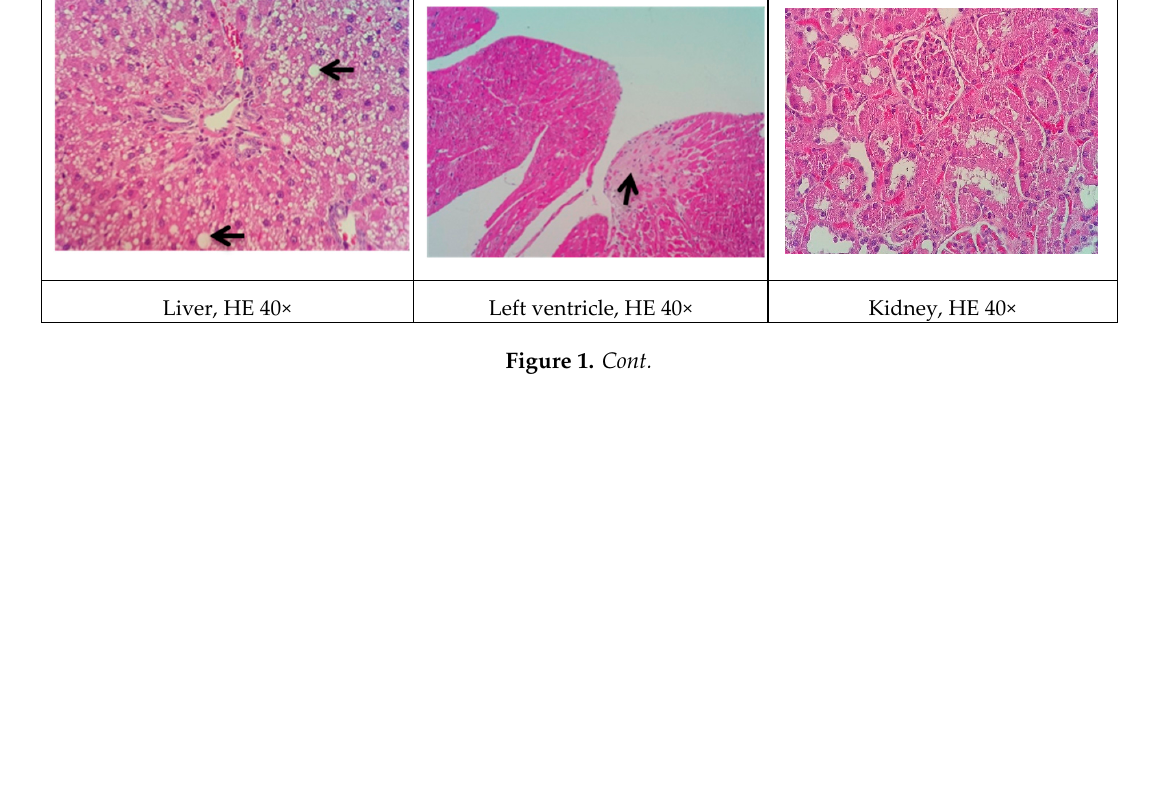
Table 9. Cardiac and arterial morphometry in the various groups over 60 days of treatment.